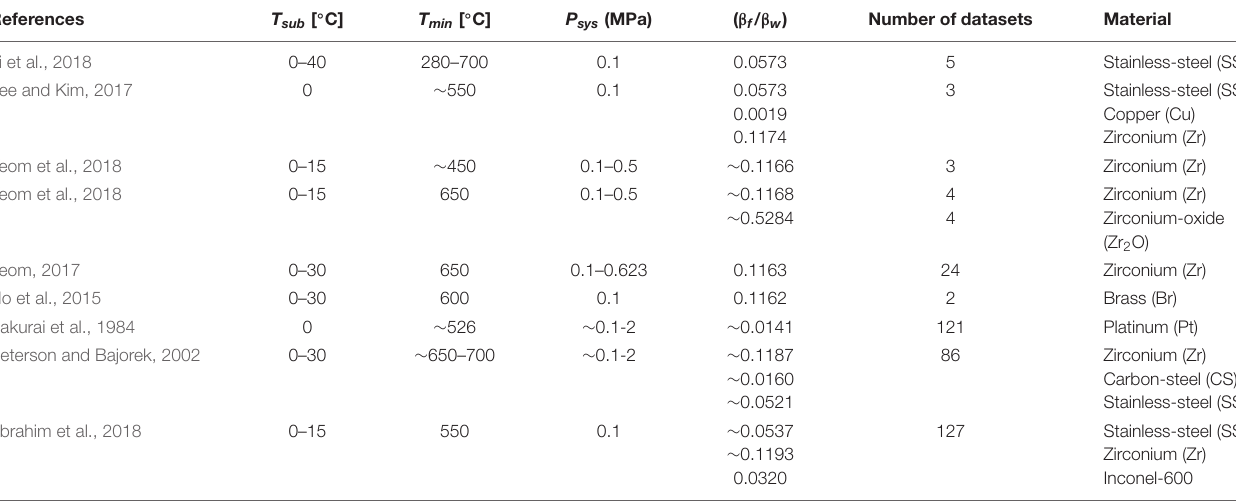
TABLE 1 | Experimental quenching conditions for the collected T min data from literature.